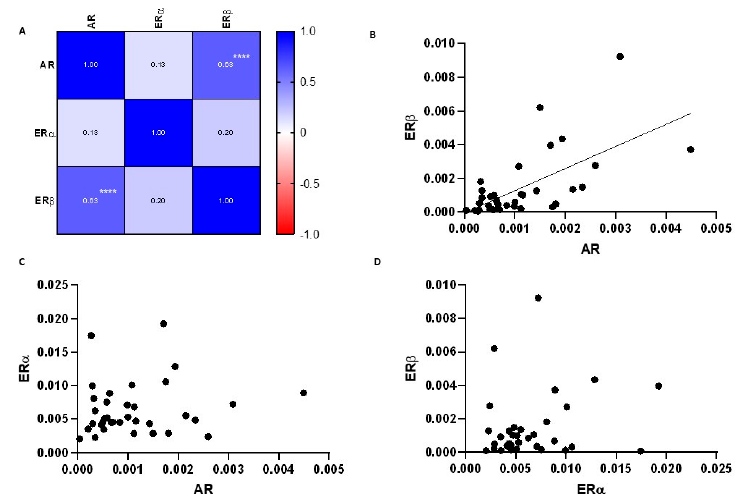
Figure 2. Correlation between steroid receptor mRNA expression in the lacrimal gland. ( A ) Correlation matrix showing correlation coe ffi cients between sex steroid receptor expression. ( B ) Sca tt er plot with simple linear regression showing a moderate positive correlation between ER β and AR expression. ( C , D ) Sca tt er plots showing the relationship between ER α and AR, and ER α and ER β expression, respectively. **** p < 0.0001.